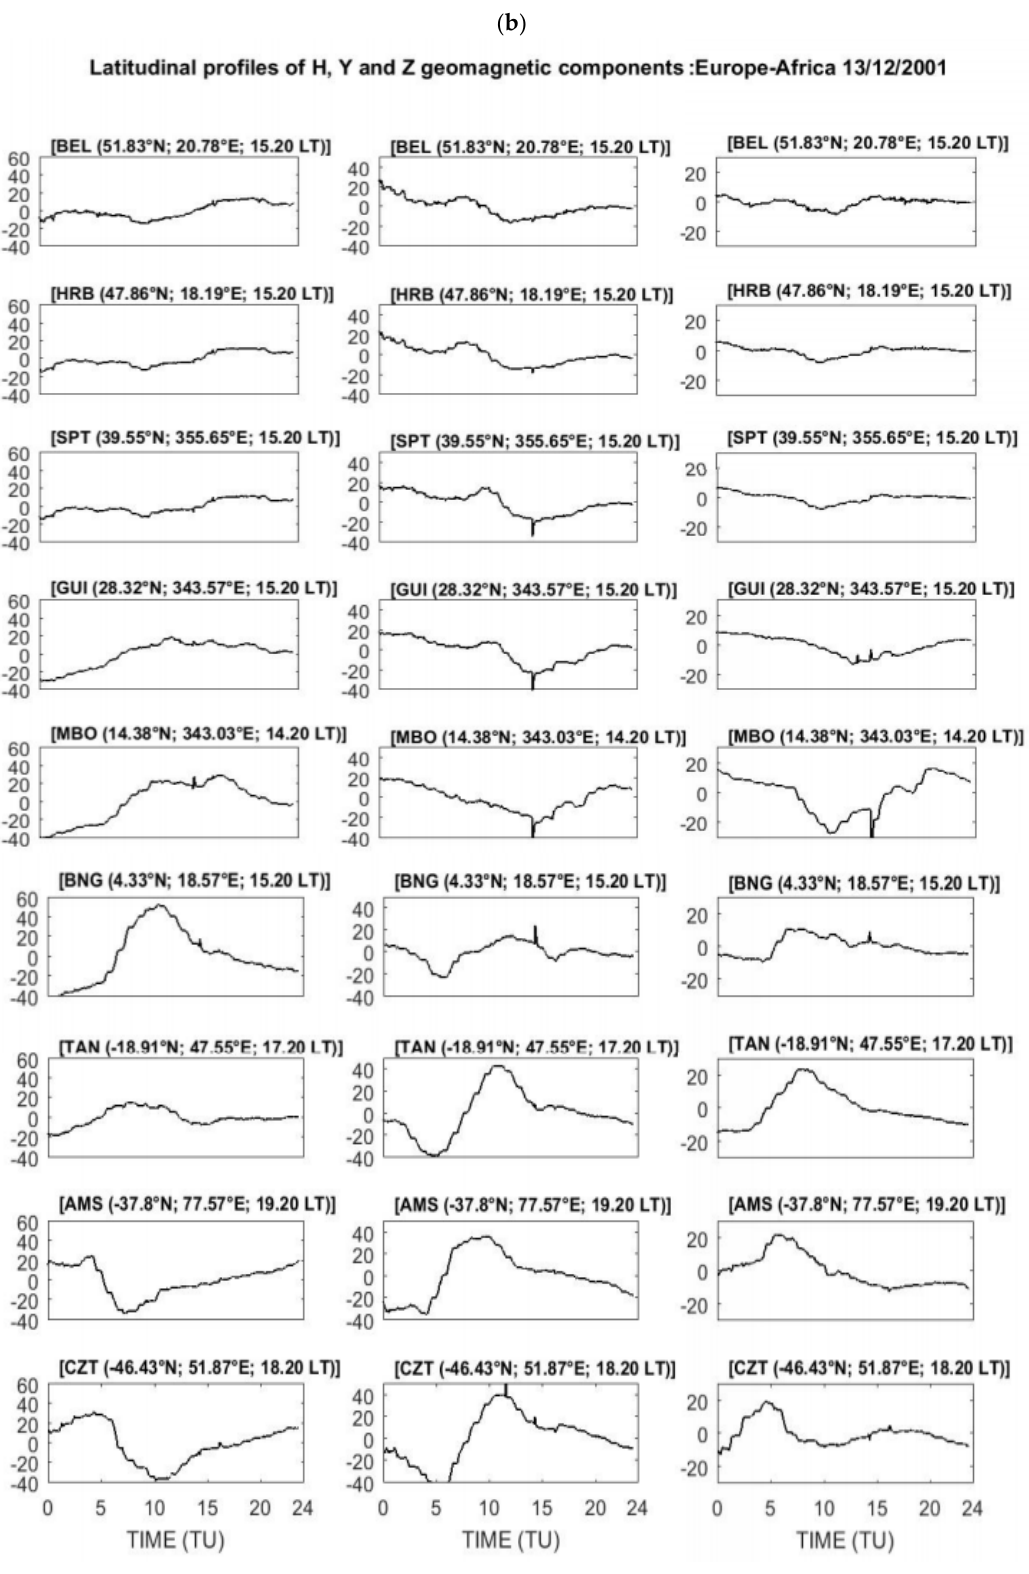
Figure 10. ( a ) Variation of horizontal H, easterly Y and vertical Z components of the geomagnetic field associated with the solar eruption class X6.2 on 13 December 2001 (American longitude sector) ( b ) Variation of horizontal H, easterly Y and vertical Z components of the geomagnetic field associated with the solar eruption class X6.2 on 13 December 2001 (Africa longitude